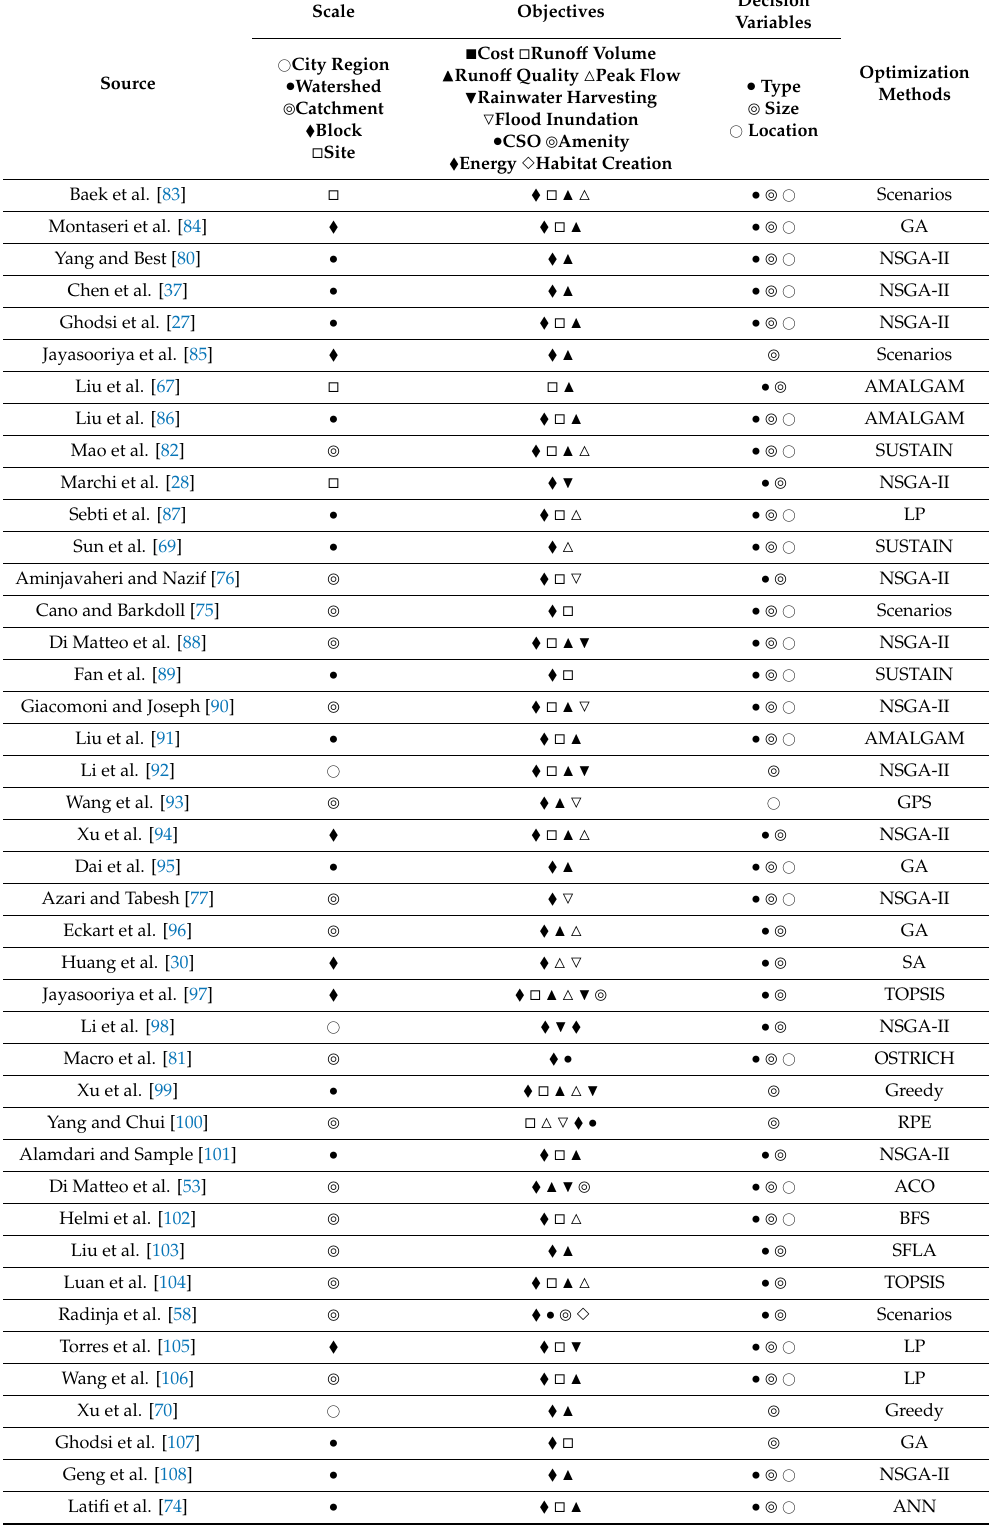
Table 1. Summary of data for optimization studies used for evaluating the GI